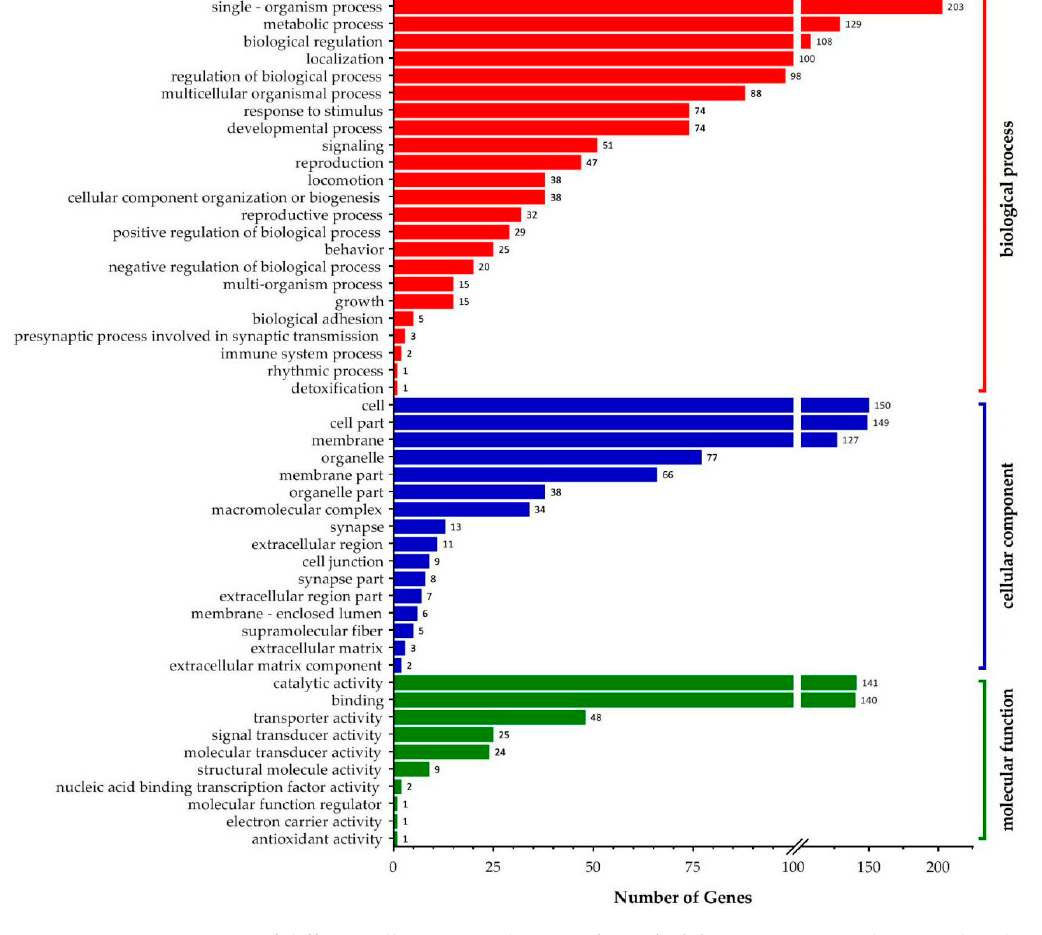
Figure 5. GO categories of differentially expressed genes of B. xylophilus in aseptic condition and with S. maltophilia .